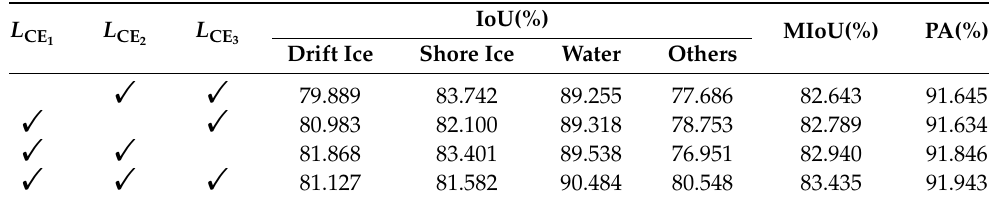
Table 2. Experiments on the effects of three auxiliary losses on the attention module. PA: Pixel accuracy. MIoU: Mean intersection over the union.